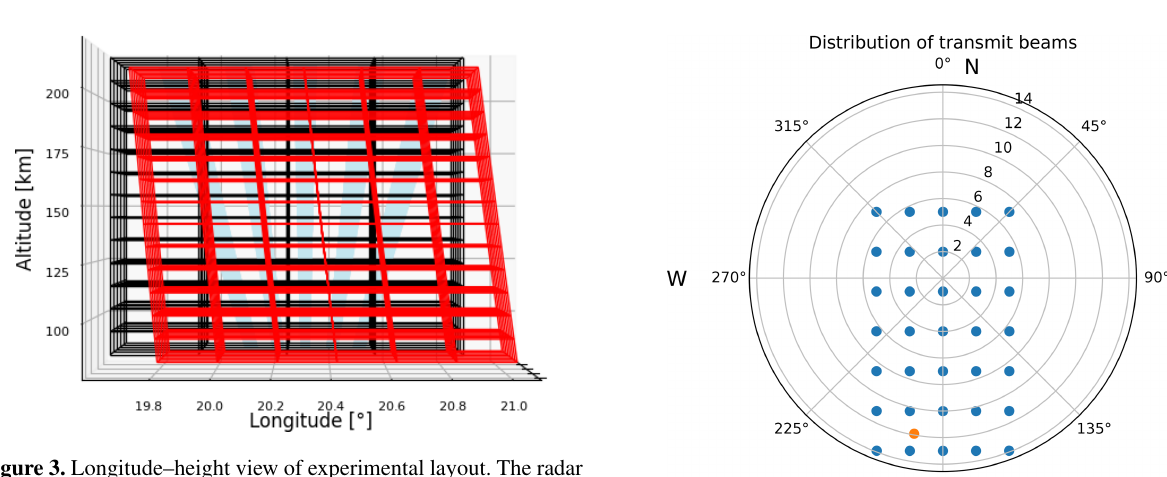
Figure 3. Longitude–height view of experimental layout. The radar beams are shown in blue, the grid for neutral wind in black and the grid for electric field in red.